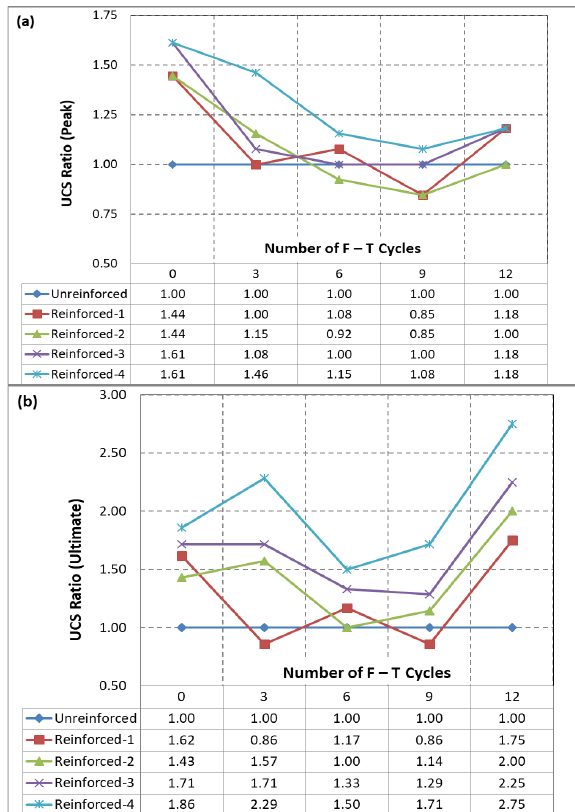
Figure 6 : Relationship between (a) the peak UCS ratio, (b) the ultimate UCS ratio and freezing–thawing cycles.